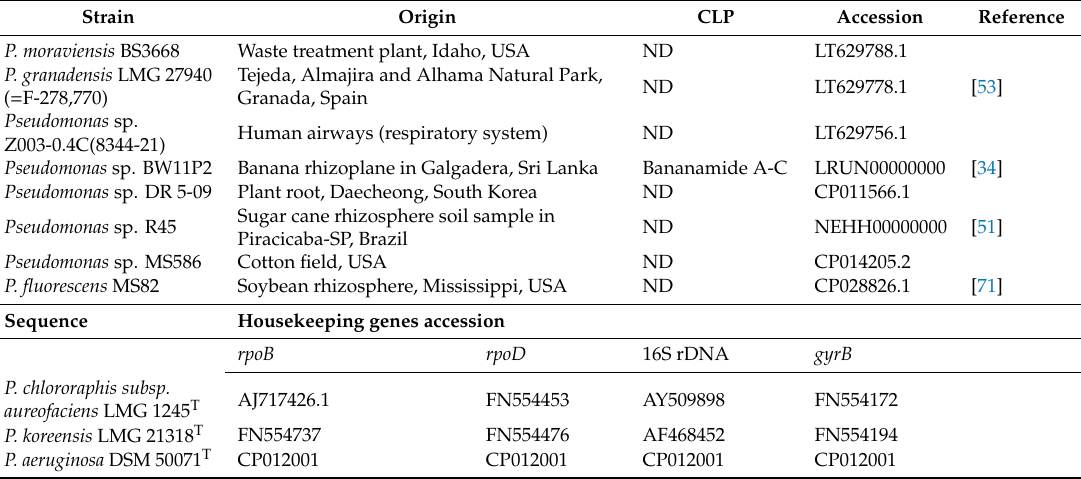
Table A5. Genomes and sequences used in this